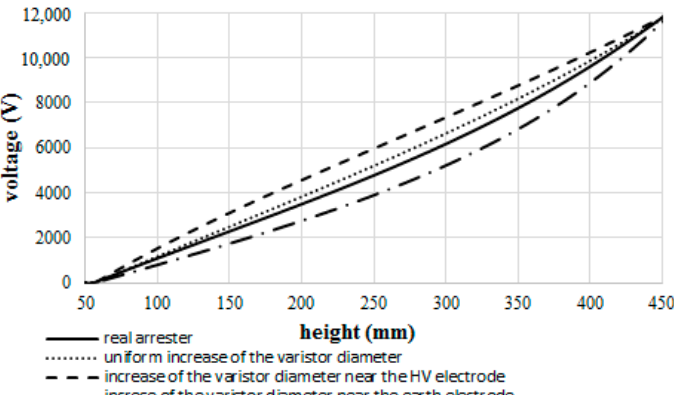
Figure 8. Comparison of the voltage distribution along the non linear resistance for the examined cases.